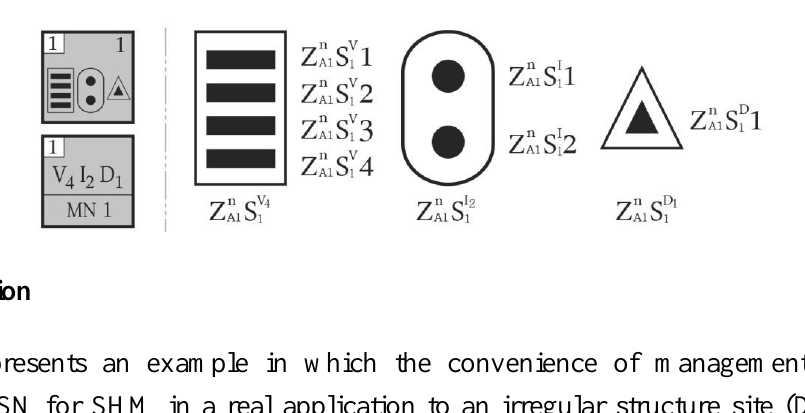
Figure 6. Notational system for each sensor of the A1